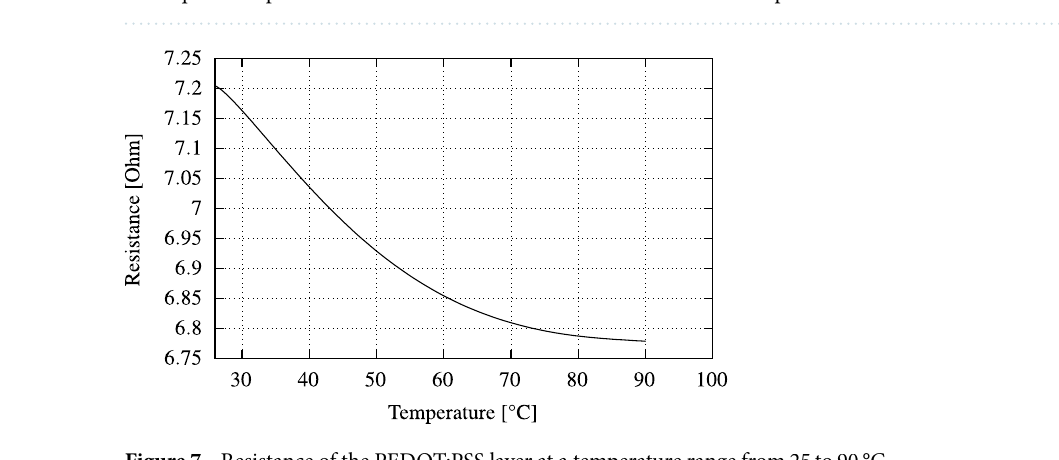
Figure 7. Resistance of the PEDOT:PSS layer at a temperature range from 25 to 90 °C.